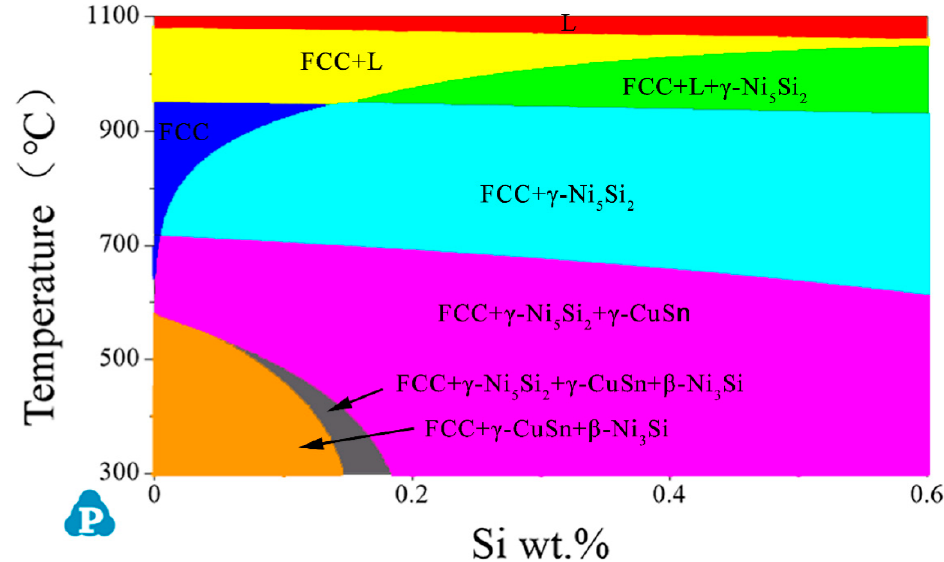
Figure 13. The simulation-calculated pseudo-binary phase diagram of the Cu–6Ni–6Sn–xSi